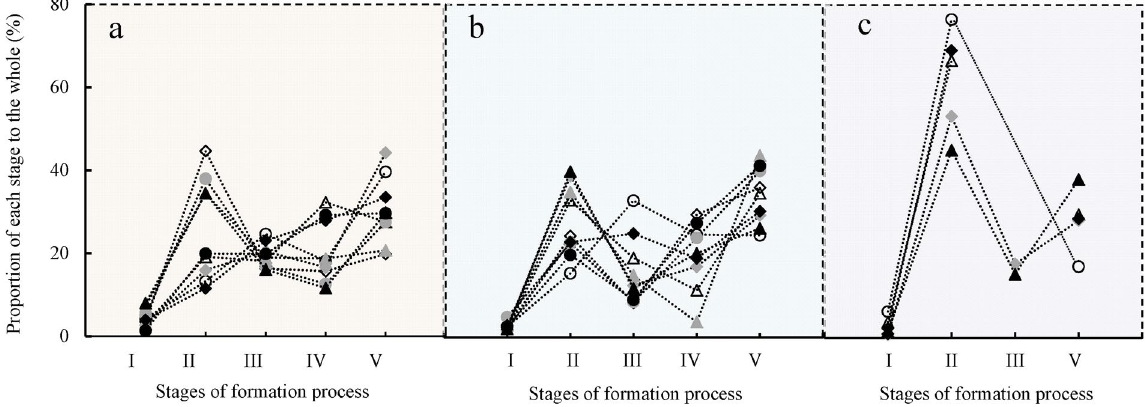
Figure 6. Ratio of the amount of gas consumed in each stage to that consumed during the whole process.